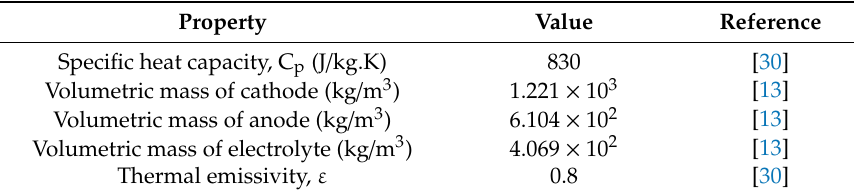
Table 2. Battery physical parameters for thermal runaway modelling.